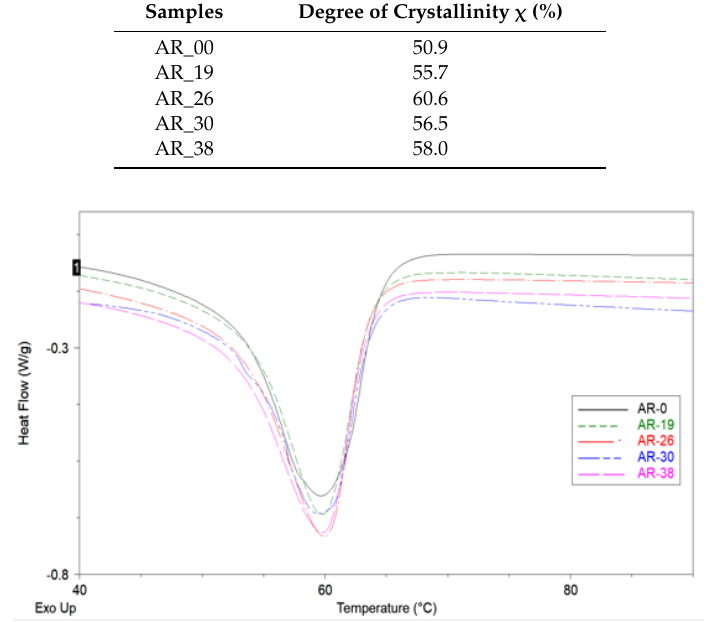
Table 3. Di ff erential scanning calorimetry (DSC) melting 1 er run. Table 3. Differential scanning calorimetry (DSC) melting 1 er run. Table 3. Differential scanning calorimetry (DSC) melting 1 er run.